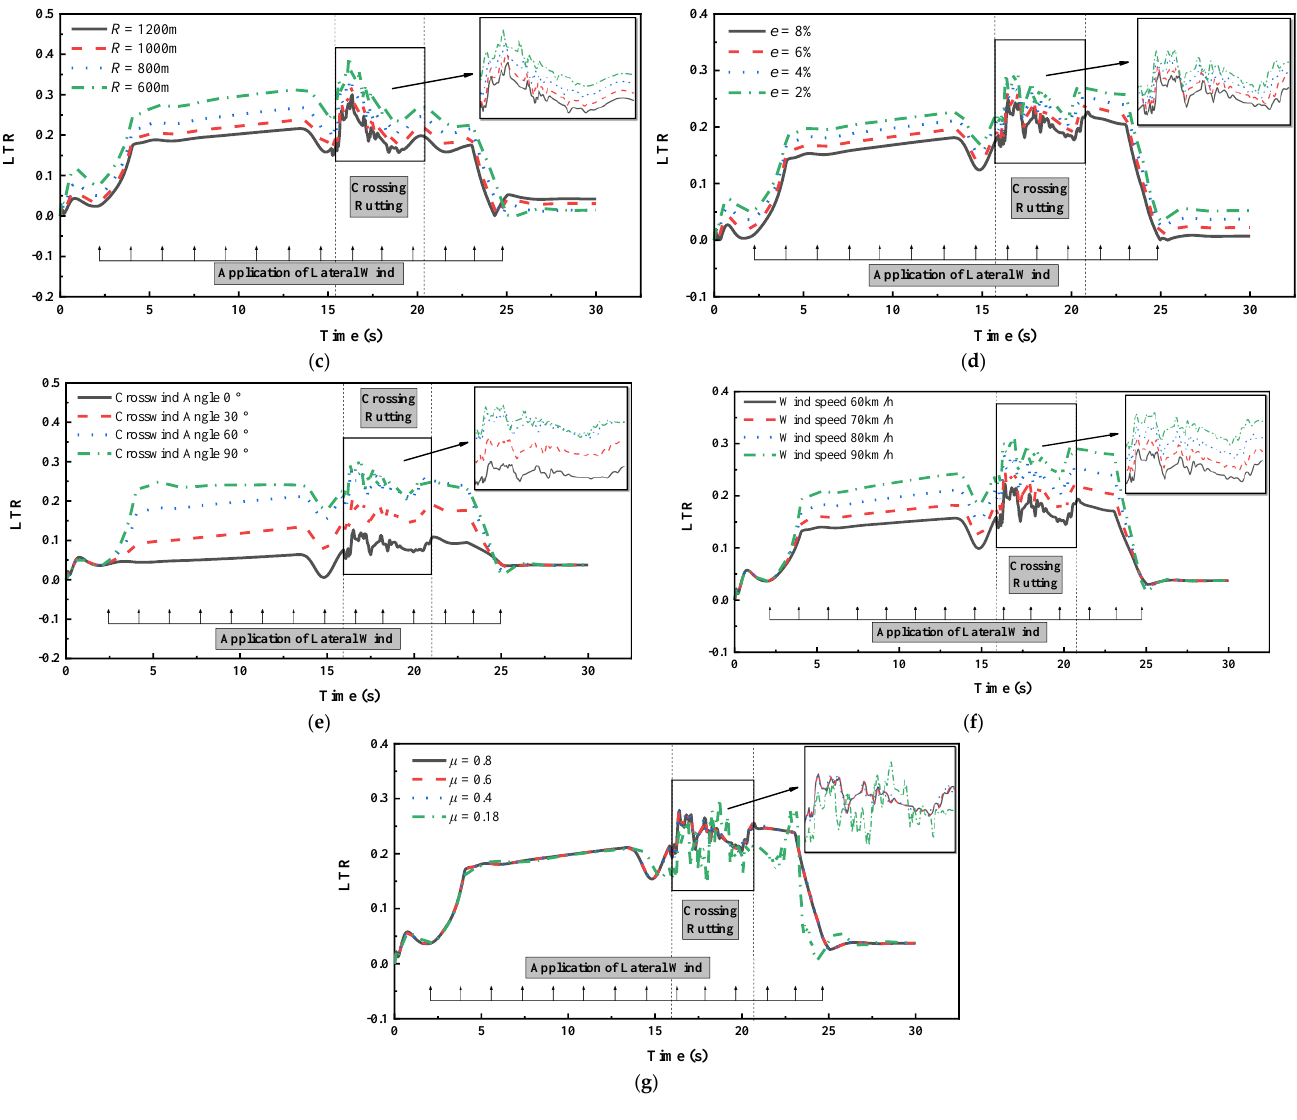
Figure 10. Change of LTR over time under various driving conditions: ( a ) Vehicle speed; ( b ) WHR of the rutting; ( c ) Radius of circular curve; ( d ) Superelevation; ( e ) Crosswind angle; ( f ) Wind speed; ( g ) Friction coefficient between road and tire.